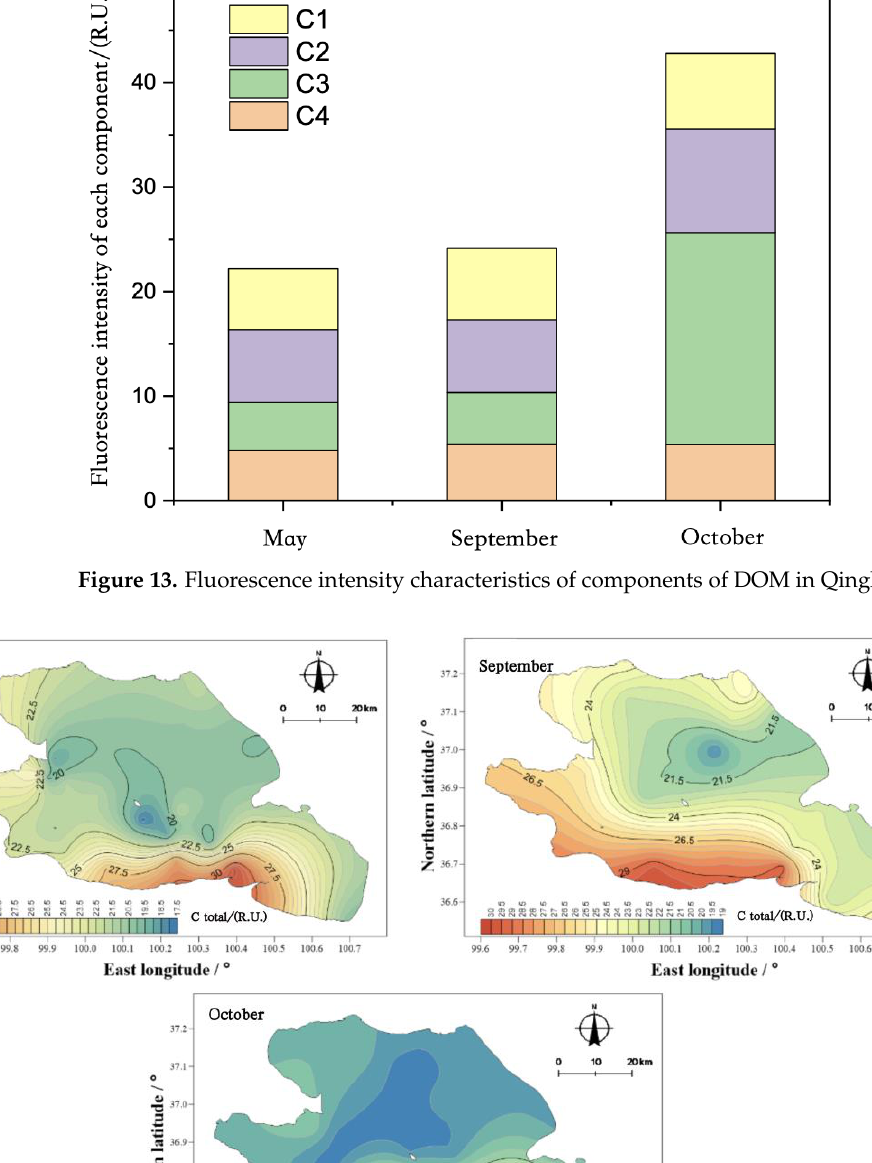
Figure 13. Fluorescence intensity characteristics of components of DOM in Qinghai Lake.